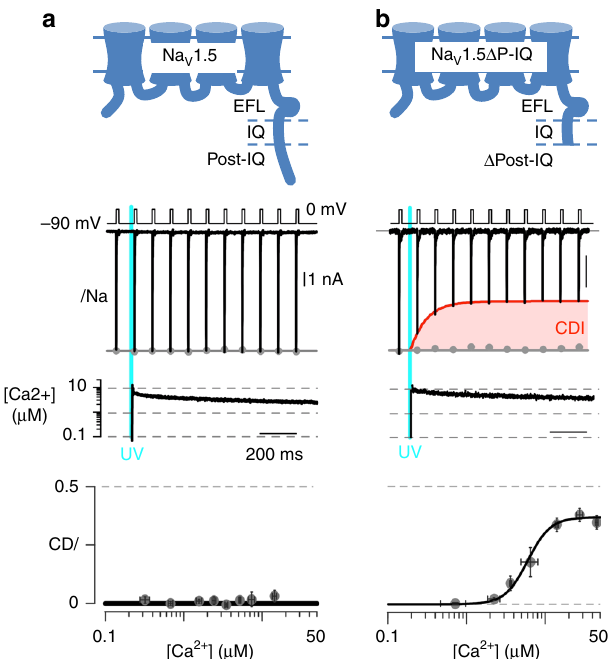
Fig. 6 Deletion of Na V 1.5 post-IQ NLBM reveals CDI. a Schematic of the sodium channel Na V 1.5 displaying CTerm and post-IQ NLBM region; currents unaffected by 10 µ M Ca 2 + . Gray dots, peak currents before uncaging. Bottom, mean ± ecm for CDI versus Ca 2 + -step amplitude. CDI = 1 − average peak I 2 + uncaging/peak Na of last three to four responses after Ca I Na before uncaging. b Schematic of Na V 1.5 displaying CTerm and the post- IQ deletion; Na + currents reduced strongly at 10 µ M Ca 2 + , the envelope of peak currents is outlined in red and the difference in peak current before and after uncaging is shaded. Current measurements of Na V 1.5 Δ P-IQ, shown as in ( a Na V 1.4-apo CaM crystallized here corresponds to an activating conformation of apo CaM bound to the Na V 1.4 CTerm. (Ca 2 + ) 4 – CaM binds with high af fi nity to the Na V 1.4 CTerm (Table 2), indicating that CaM remains bound to the CTerm at elevated Ca 2 + . The crystal structure of (Ca 2 + ) 4 – CaM in complex